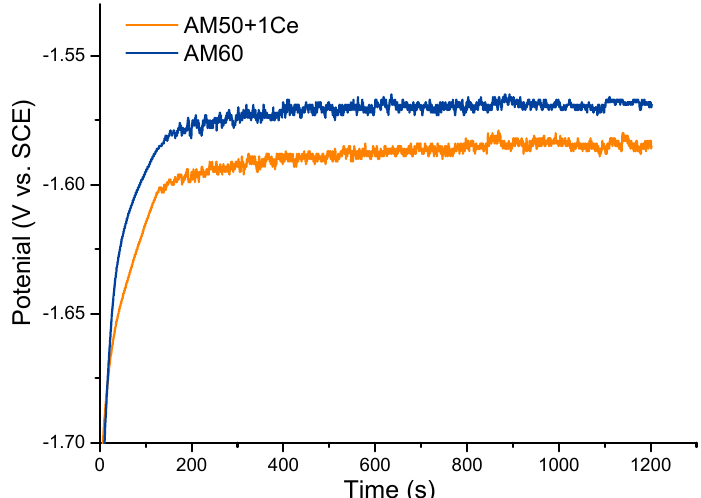
Figure 10. The open circuit potential of HPDC AM50+1Ce and AM60 magnesium in 3.5wt% NaCl solution. Table 2. Fitting results from polarization curves of HPDC AM50+1Ce and AM60 magnesium alloys in 3.5wt% NaCl solution.